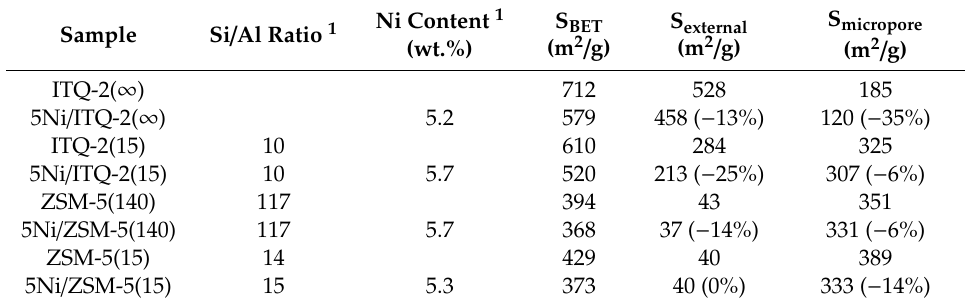
Table 1. Textural properties and chemical composition of the supports and the corresponding 5